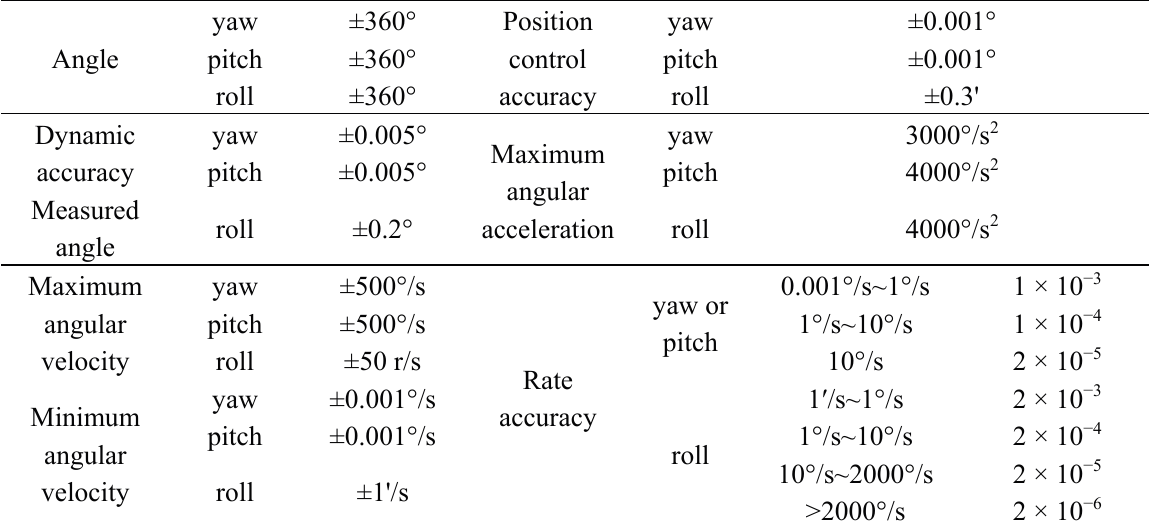
Figure 8. The experimental platform. Table 2. The main specifics of the three axis rate